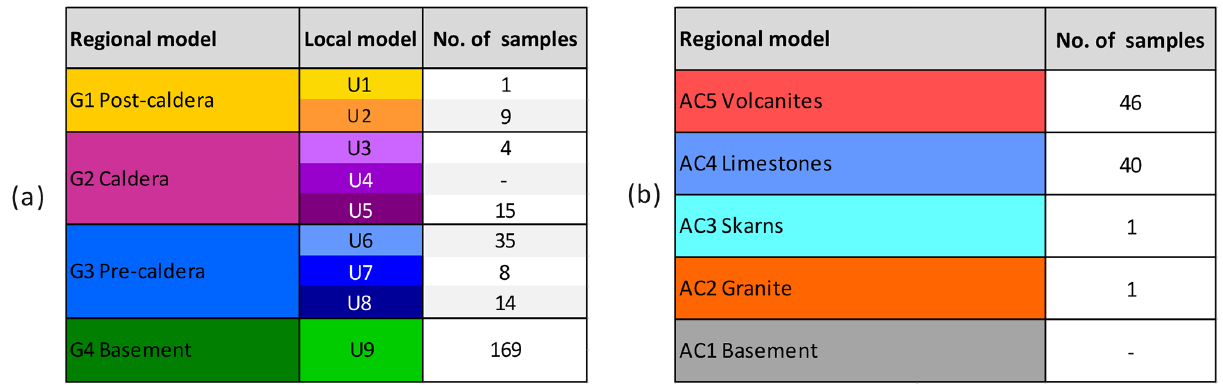
Figure 7. Number of collected samples (outcrop and reservoir core samples) per model unit for the regional and local models of the Los Humeros (a) and Acoculco (b) geothermal